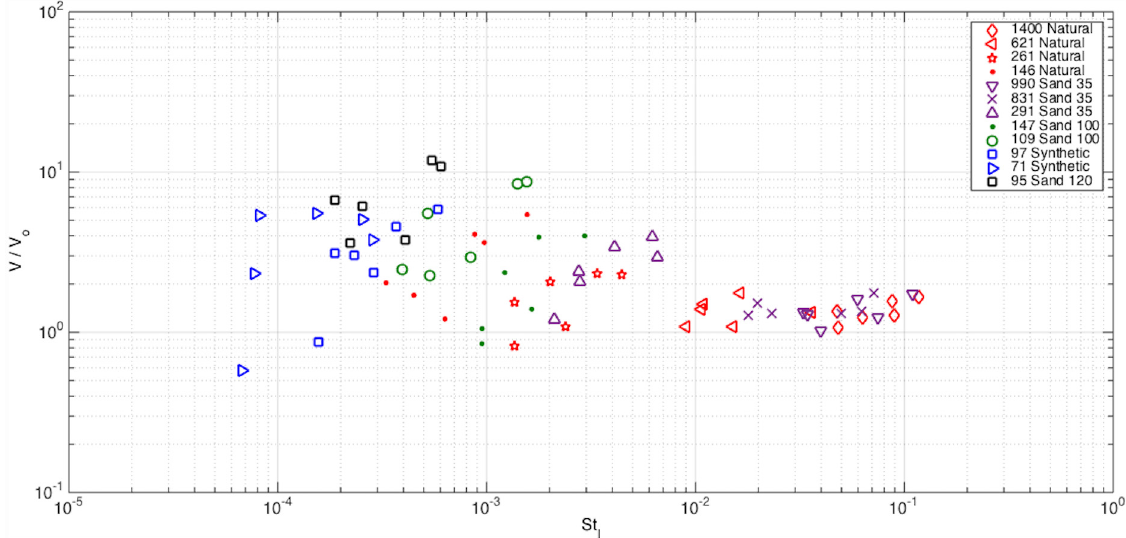
Fig 9. Normalized settling velocity of particles versus Stokes number based on the integral time